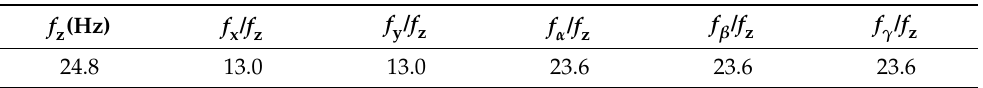
Figure 3. ( a )~( f ) The first six order vibration modal analysis results of the Micro-Electro-Mechanical Systems (MEMS) sensor chip. The resonant mode frequencies are approximately 24.8 Hz, 321.5 Hz, 321.6 Hz, 584.9 Hz, 585.4 Hz, 586.1 Hz, respectively. Table 2. Ratio of insensitive axis frequency to sensitive axis frequency based on the micro-mechanical sensor structure. (A decimal